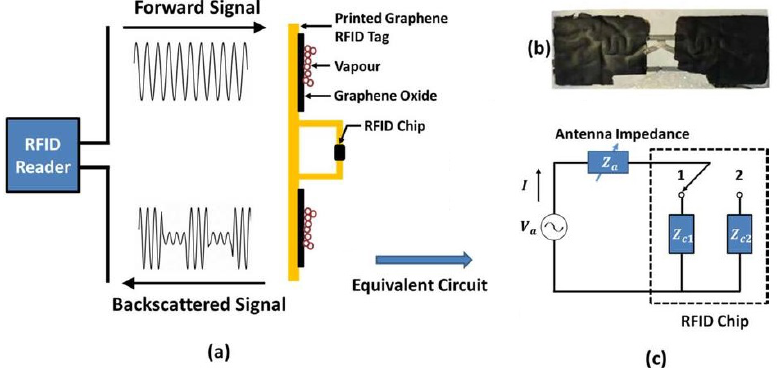
Figure 8. ( a ) Operating principle of the chip-based antenna resonance RFID sensor. ( b ) Printed with a 15 µ m thick layer of graphene oxide on top. ( c ) The equivalent circuit of the sensor